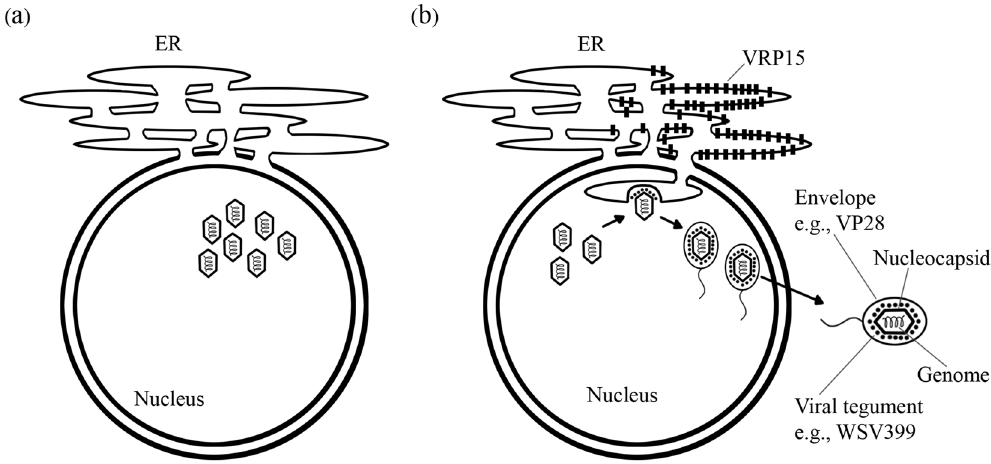
Figure 8. Proposed role of Pm VRP15 during WSSV infection. ( a ) In the absence of Pm VRP15, replicated WSSV genomes accumulate in the nucleus. ( b ) Overexpressed of Pm VRP15 at ER facilitates viral nuclear exit and